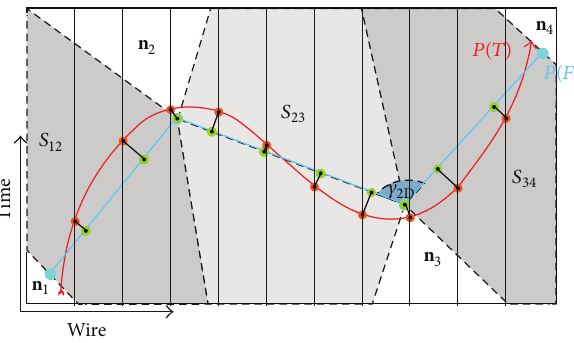
Figure 6: Schematic view of the track 𝑃(𝑇) (red) and fit 𝑃(𝐹) (blue) projections in the wire plane. 2D hits (orange dots) are marked on the track projection intersections with wires; hit projections to 𝑃(𝐹) aremarkedasgreendots;hitdistancesto 𝑃(𝐹) aremarkedwithblack sections. Hits from grey shaded regions 𝑠 𝑥𝑦 are assigned to segments; hits from white regions 𝑛 𝑥 are assigned to nodes. Indicated angle 𝛾 2 isthe2Dprojectionofthe 𝛾 anglebetweenthefitsegmentsin3D(see (7) in